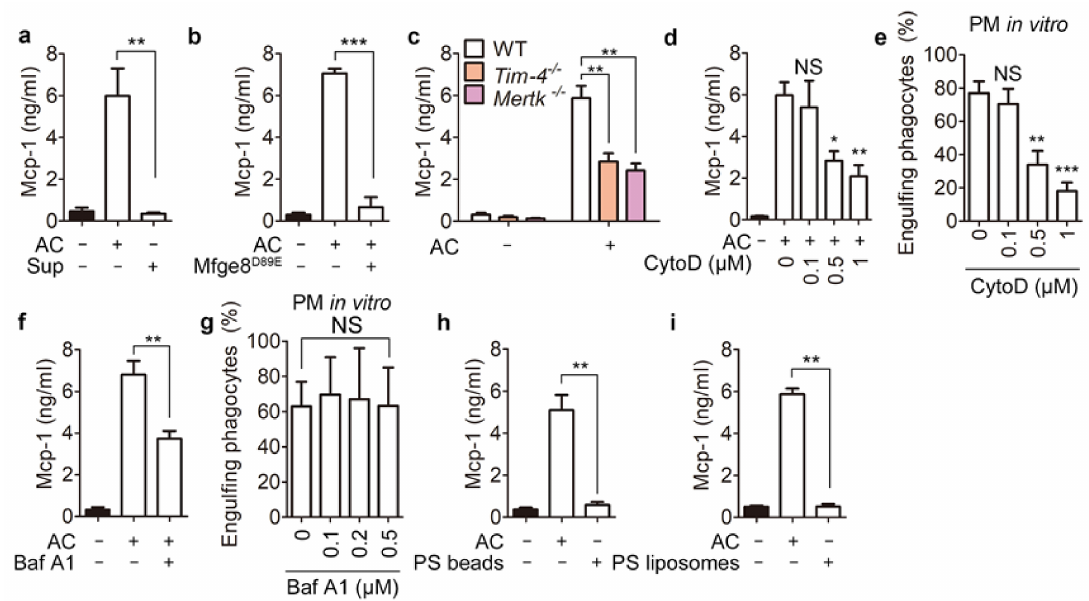
Figure 2. Degradation of apoptotic cells in phagocytes is necessary for Mcp-1 secretion. ( a ) Peritoneal macrophages were incubated with apoptotic cells or apoptotic supernatants for 8 h. The levels of Mcp-1 in conditioned medium from the cells were measured using an ELISA. ( b ) Peritoneal macrophages were incubated with apoptotic cells treated with or without Mfge8 D89E (10 µ g/mL) for 8 h. The levels of Mcp-1 were measured as in panel ( a ). ( c ) Peritoneal macrophages derived from WT , Tim-4 − / − , or Mertk − / − mice were incubated with apoptotic cells for 8 h and then the levels of Mcp-1 in conditioned medium from the cells were measured using an ELISA. ( d , e ) Peritoneal macrophages were incubated with apoptotic cells in the presence of the indicated concentrations of cytochalasin D for 8 h. The levels of Mcp-1 in conditioned medium ( d ) and efferocytosis by the cells ( e ) were measured. Peritoneal macrophages were incubated with apoptotic cells in the presence of 0.5 µ M ( f ) or the indicated concentrations ( g ) of bafilomycin A1. The levels of Mcp-1 in conditioned medium ( f ) and efferocytosis by the phagocytes ( g ) were evaluated. ( h , i ) Peritoneal macrophages were incubated with apoptotic cells, PS beads, or PS liposomes for 8 h. The levels of Mcp-1 in conditioned medium were measured as in a. All data are shown as the mean ± SEM. * p < 0.05, ** p < 0.01, *** p < 0.001. NS, not significant; PM, peritoneal macrophages; AC, apoptotic cells; Sup, supernatants; CytoD, cytochalasin D; Baf A1, bafilomycin A1; PS,